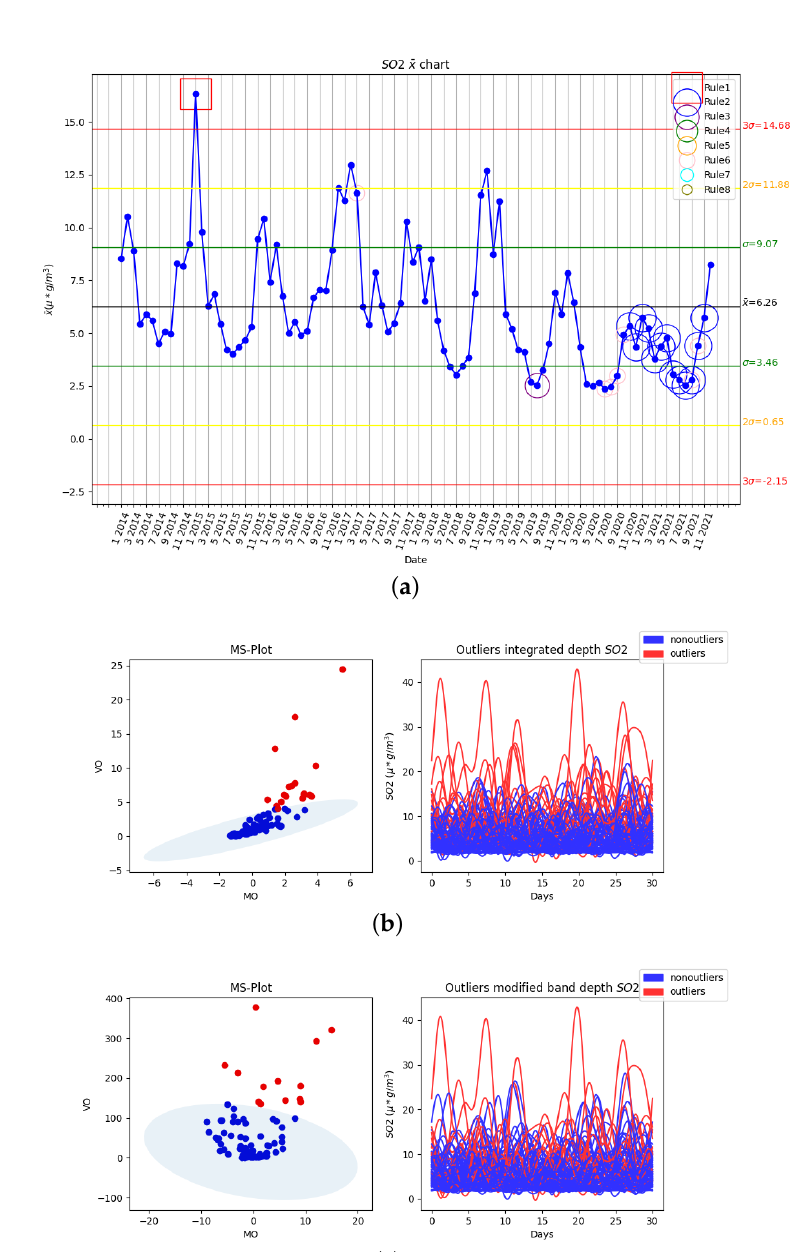
Figure 5. Results of the second phase of the SO 2 analysis: ( a ) ¯ x chart with the monthly rational subgroups and the Nelson rules implemented; ( b ) (left) Cartesian representation of the magnitude and shape outlyingness of each function with the integrated depth; (right) functional plot of the SO 2 values of each month; ( c ) (left) Cartesian representation of the magnitude and shape outlyingness of each function with the modified band depth; (right) functional plot of the SO 2 values of each